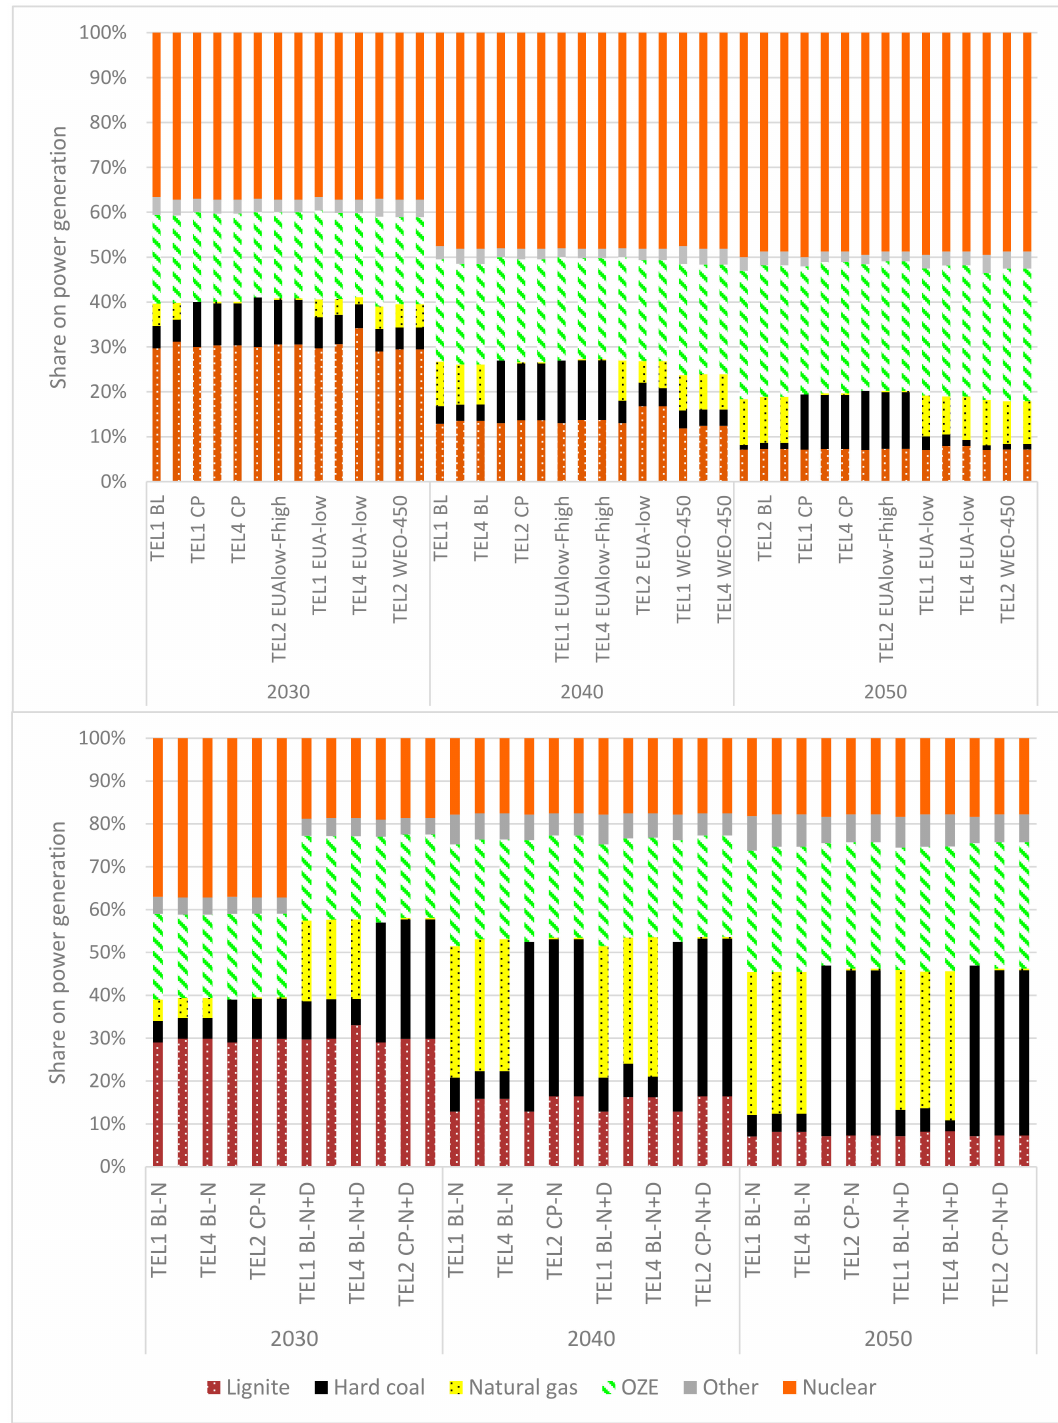
Figure 7. Shares of fuels on power generation in selected years and